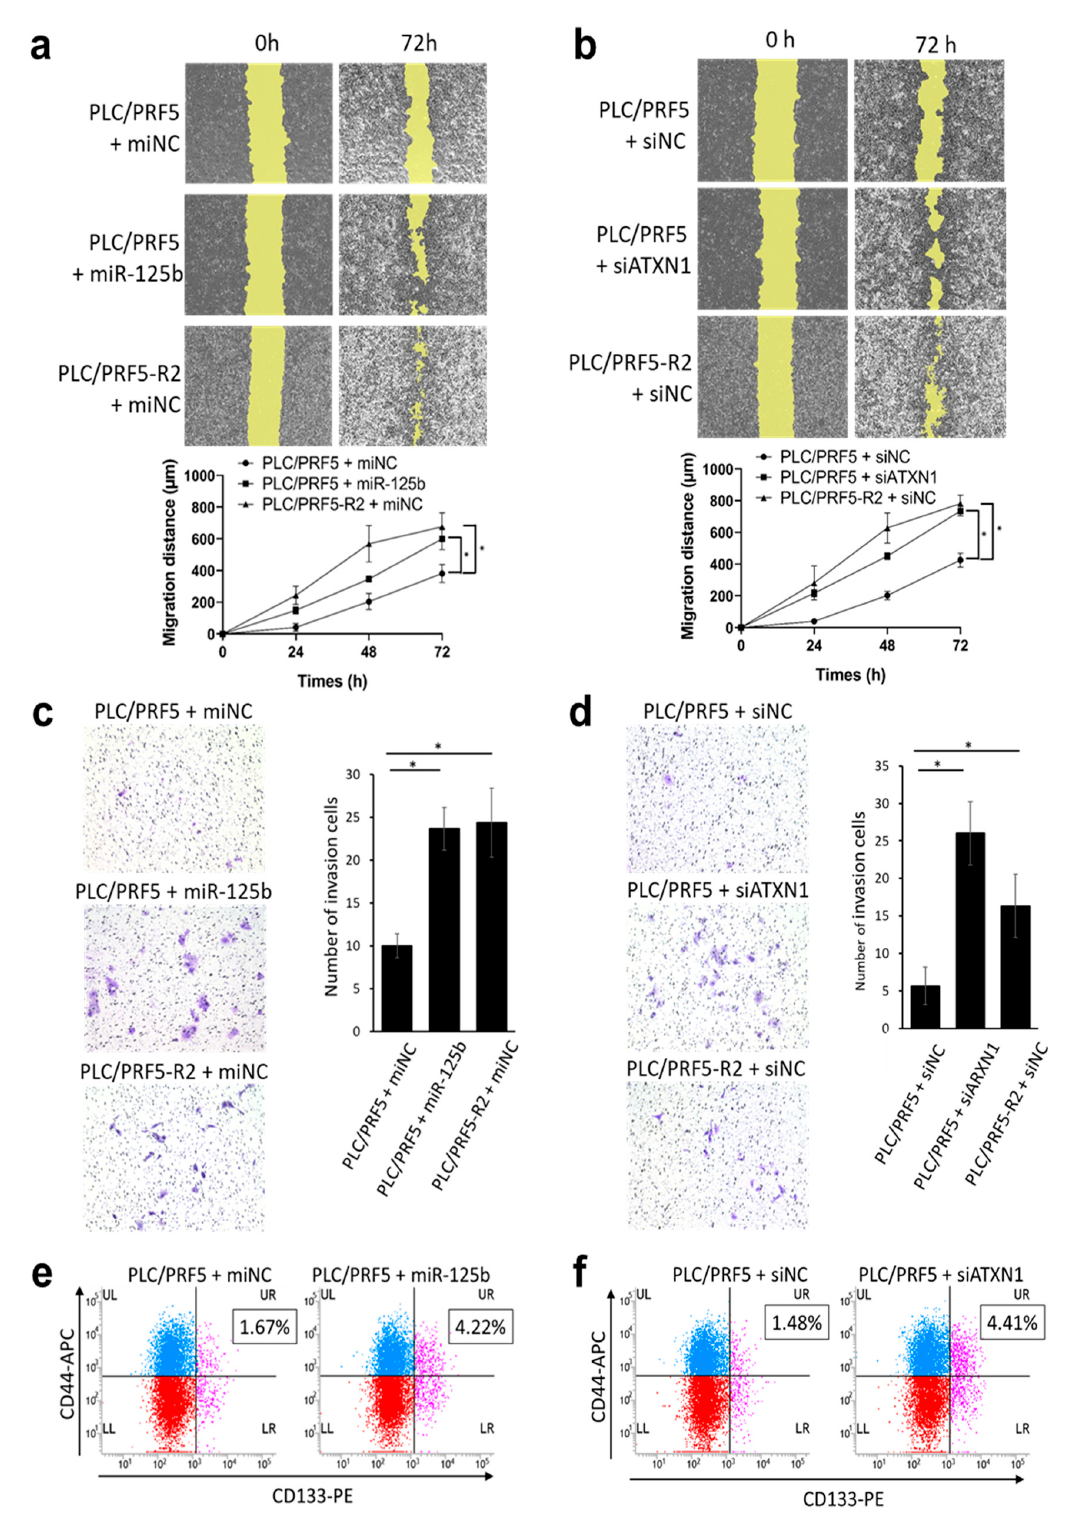
Figure 5. Forced expression of miR-125b-5p or knockdown of ATXN1 gene increases migration, invasion capability, and cancer stemness of HCC cell lines. ( a ) Representative image of the wound-healing assay in PLC/PRF5-miNC,